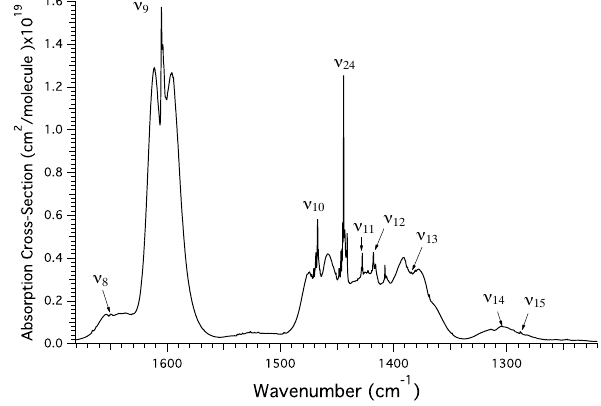
Figure 4. Quantitative infrared spectrum showing C = C stretching and CH bending modes of isoprene. Absorption cross sections are given in Naperian units (cm 2 molecule − 1 ) × 10 19 for the composite spectrum recorded at